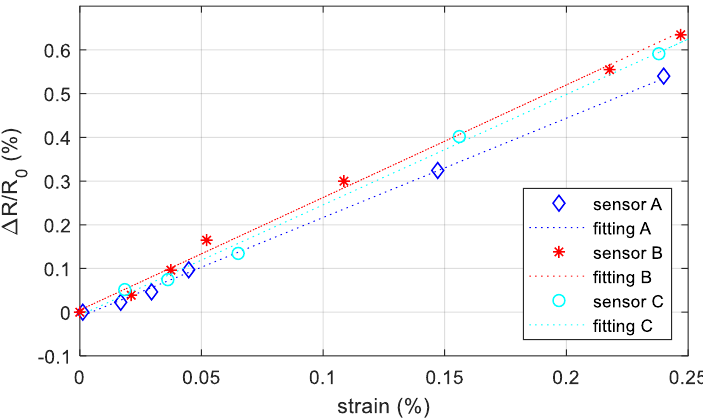
Figure 9. Resistance change with respect to the starting resistance (no external loads) versus the measured strain in the area including the sensor for three conduits equipped with own strain gauge. The points are the measurements data, while the dotted line is the best-fit line using the LLS method.